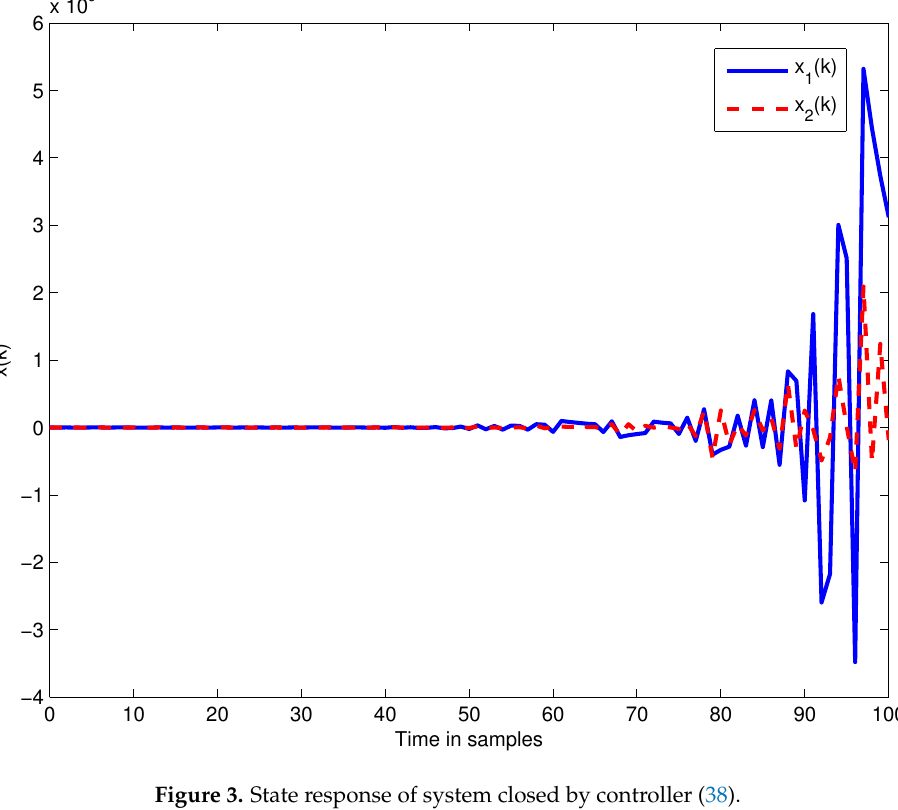
Figure 3. State response of system closed by controller (38).